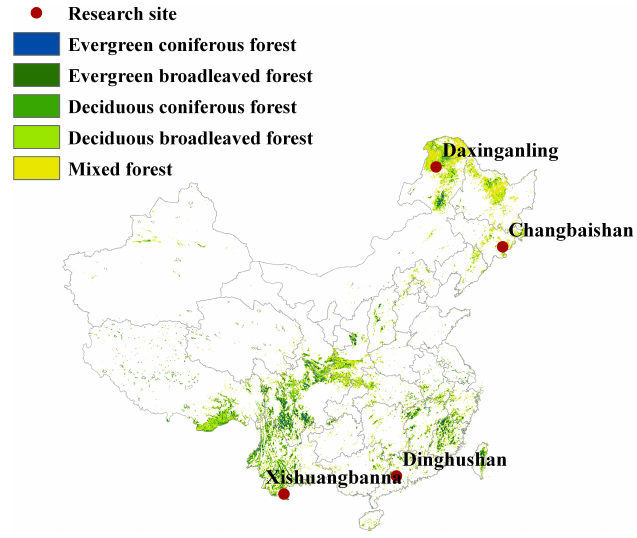
Fig. 1. Spatial distribution of soil CO 2 and CH 4 fluxes measure- ment sites in eastern